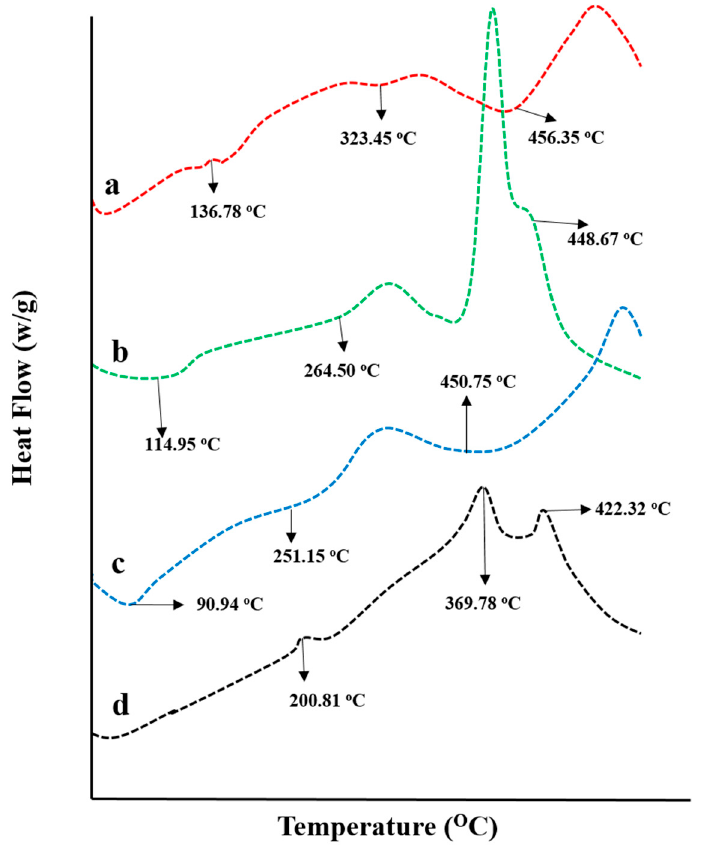
Figure 6. DSC thermograms of ( a ) capecitabine, ( b ) fenugreek extract, ( c ) chitosan, and ( d ) drug- loaded hydrogel.